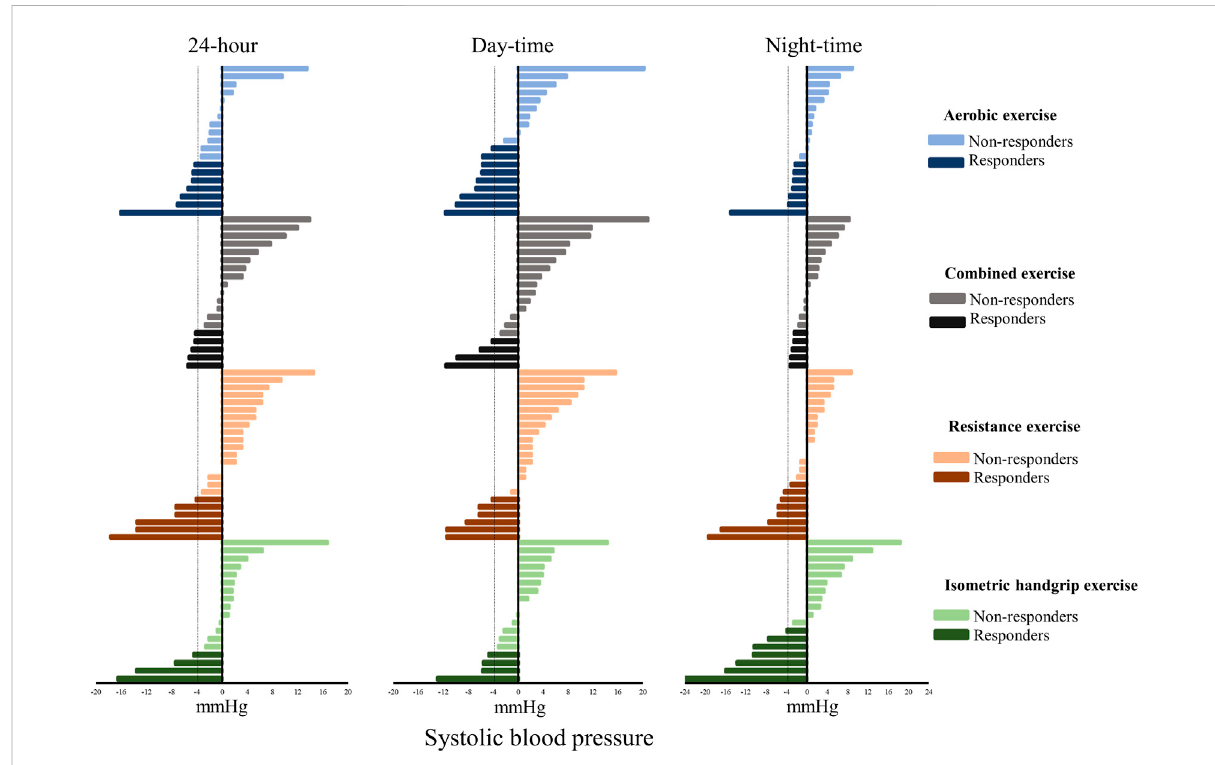
FIGURE 2 Individual changes in systolic blood pressure (exercise session minus control session). Dashed line: Minimal detectable change (4